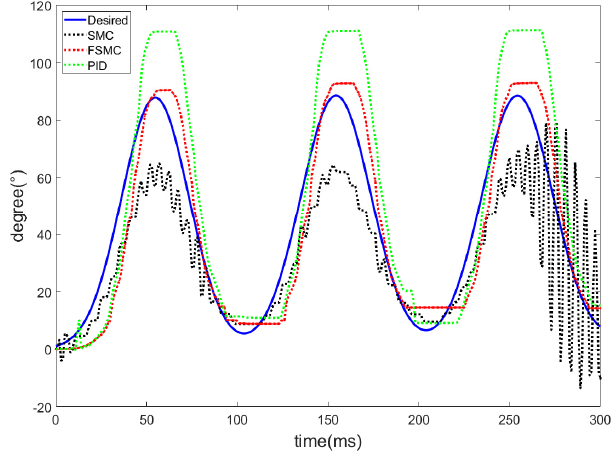
Figure 17. The trajectory of shoulder joint J 3.